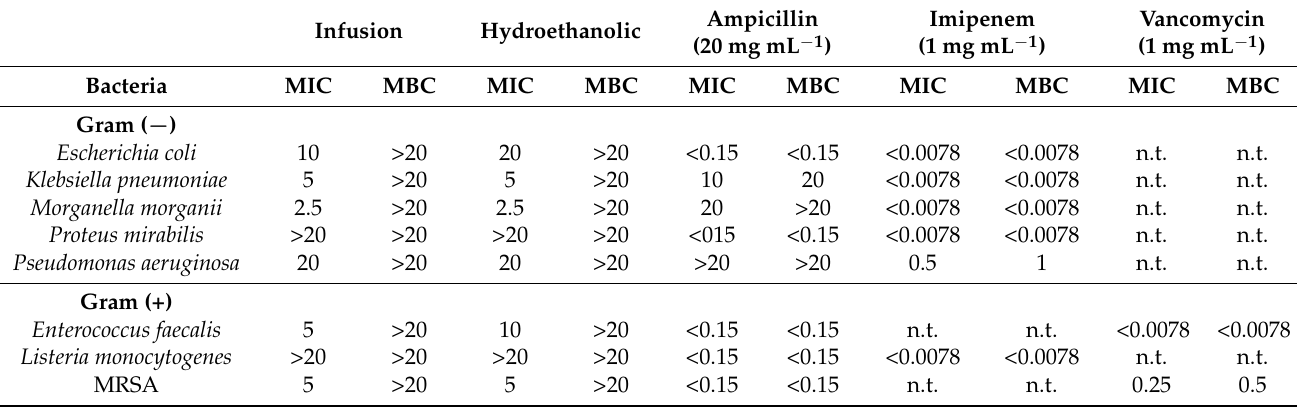
Table 6. Antimicrobial activity (MIC and MBC, mg mL − 1 ) of L. canadensis infusion preparations and hydroethanolic